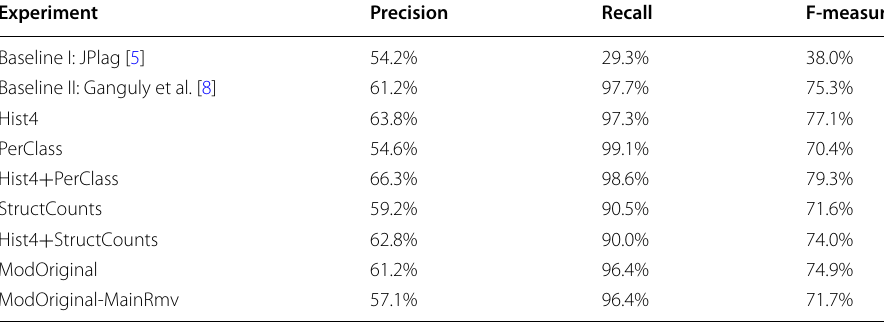
Table 9 The precision, recall, and F-measure results of the performed experiments Experiment Precision